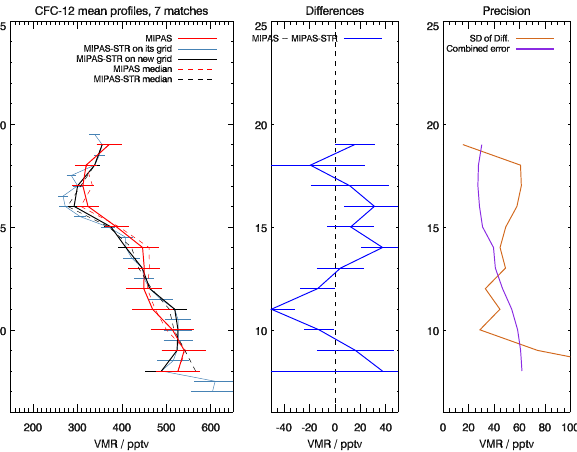
Figure 19. Comparison of mean profiles of MIPAS CFC-12 (left panel, continuous red line) and MIPAS-STR (left panel, continuous black line) for seven collocated measurements taken during a flight on 2 March 2010. The error bars consist of the total error without the spectroscopy error for both MIPAS and MIPAS-STR. The dashed lines show the median of each data set. The middle panel shows the mean difference (blue) of these profiles and the standard error of the mean. The right panel shows the combined error (purple) of the instruments and the standard deviation of the differences